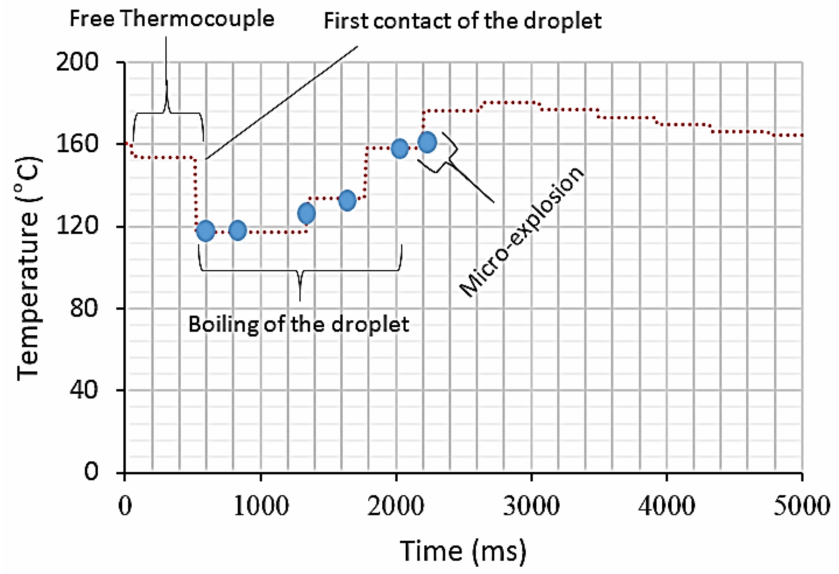
Figure 6. Temperature evolution of case